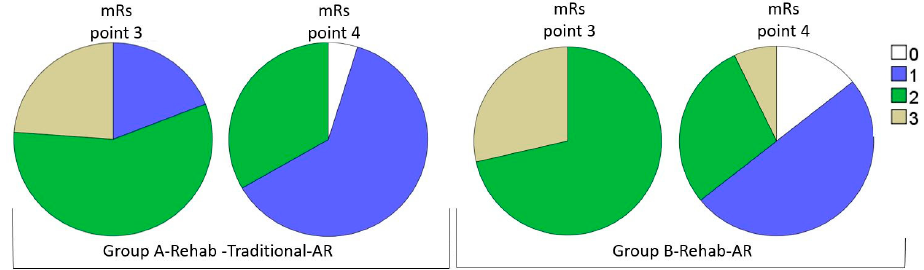
Figure 2. mRS scores during AR-based rehabilitation in Groups A and B. Comparisons of groups between observation points: A-Rehab-Traditional-AR: P 3-4 < 0.001 *; B-Rehab-AR: P 3-4 < 0.001 *. Comparisons between groups at observation points: mRS 3: P A-B = 0.33; mRS 4: P A-B = 0.93. * Significant; p <